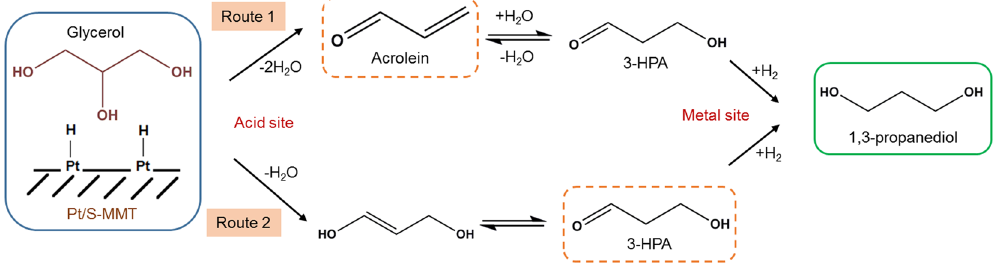
Figure 7. The possible routes of 1,3-PDO formation in vapour phase glycerol hydrogenolysis over Pt/S-MMT catalyst in a fixed bed reactor under atmospheric